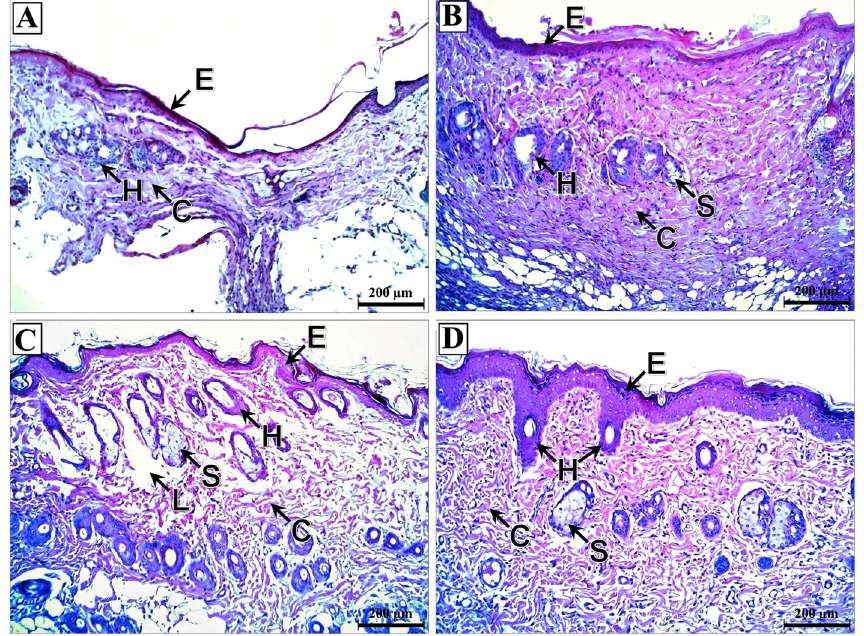
Figure 4. Photomicrographs of skin flap sections of the induced flap ischemia subgroups. ( A ) Control subgroup showing massive thinning of both epidermis (E) and dermis with loss of demarcations between the epidermal layers and extensive disorganization of the dermal collagen fibers (C). The hair follicles (H) are massively atrophied with the complete absence of sebaceous glands. ( B ) Nitroglycerin subgroup showing thin epidermis (E) with loss of the demarcations between its layers. The dermis reveals well-developed moderately disorganized collagen fibers (C) and massively atrophied hair follicles (H) and sebaceous glands (S). ( C ) BoTA subgroup showing relatively thin epidermis (E) and dermis with under-developed disorganized collagen fibers (C) having areas of their complete loss (L). The hair follicles (H) and sebaceous glands (S) are massively degenerated. ( D ) Clopidogrel subgroup showing restoration of the thickness of the epidermis (E) with distinct demarcations between its layers. There is a mild irregularity of the dermal collagen fibers (C), and